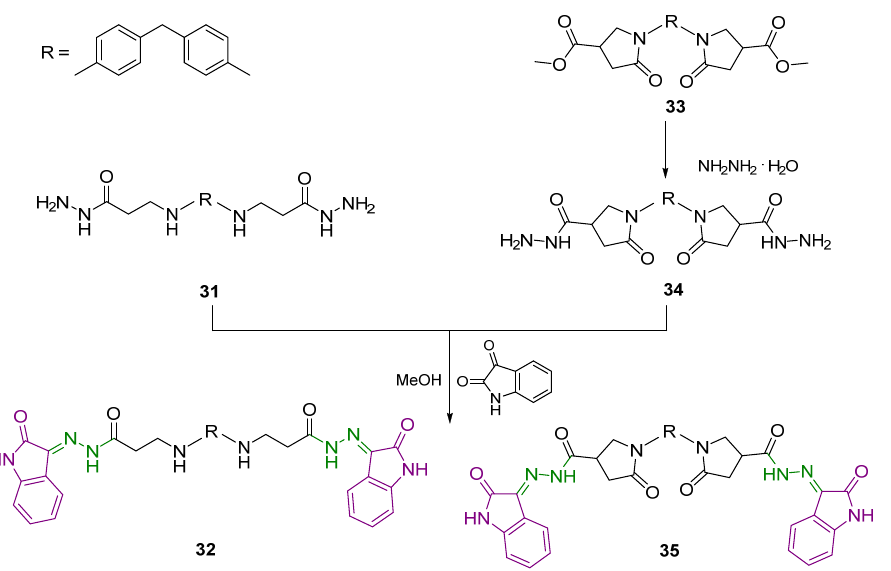
Scheme 3. Synthesis of hydrazones 32 and 35 . Azomethine group is marked in green colour and 2-oxindole moiety is represented in purple colour.